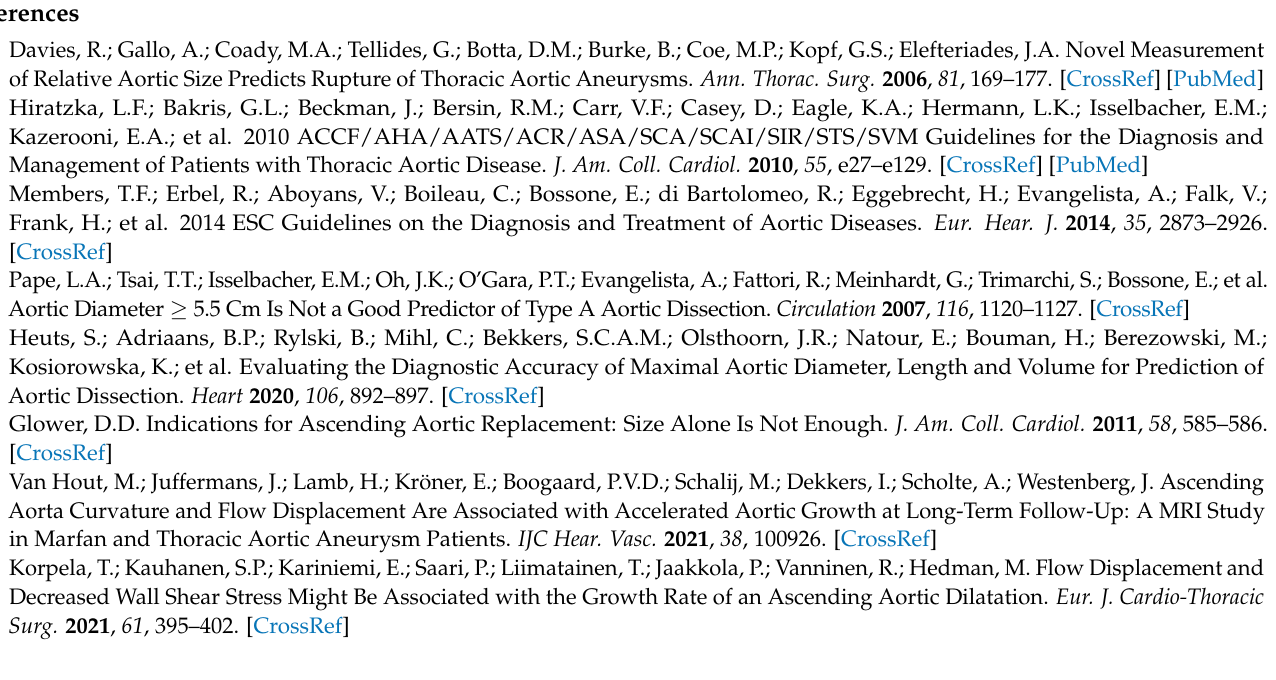
flow displacement; Figure S2: Bland–Altman plots for the flow jet angle; Figure S3: Bland–Altman plots for the wall shear stress magnitude; Figure S4: Bland–Altman plots for the axial wall shear stress; Figure S5: Bland–Altman plots for the circumferential wall shear stress; Figure S6: Bland–Altman plots for the wall shear stress angle; Figure S7: Bland–Altman plots for the vorticity norm; Figure S8: Bland–Altman plots for the absolute helicity; Figure S9: Bland–Altman plots for the absolute local normalized helicity volume; Figure S10: Bland–Altman plots for the volume; Figure S11: Bland– Altman plots for the centerline length; Figure S12: Bland–Altman plots for the maximal diameter; Figure S13: Bland–Altman plots for the curvature radius; Table S1: Characteristics of the 4D flow MRI Sequence; Table S2: Intra- and interobserver reproducibility: results of the training cohort; Table